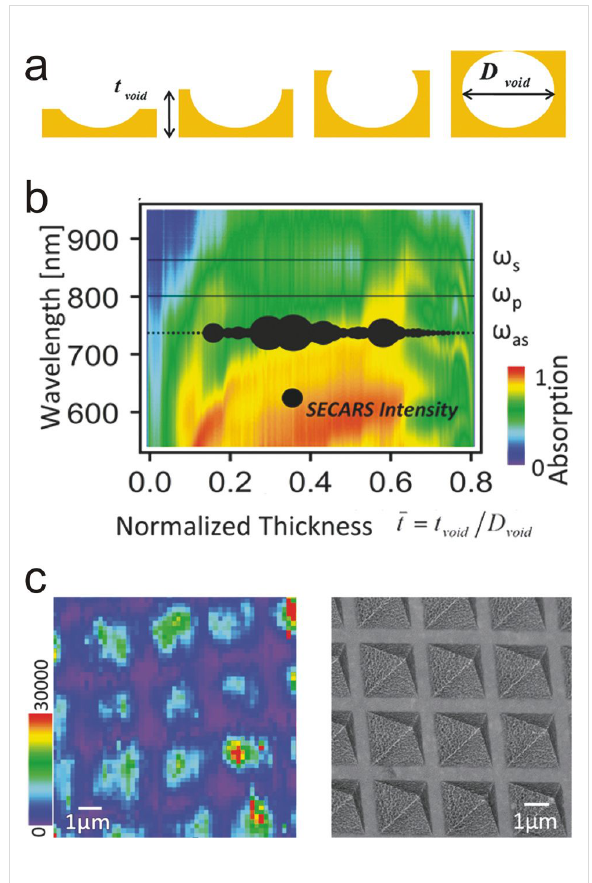
Figure 10: (a) Schematic representation of the gold nanovoids. Depending on the gold film thickness, the voids present various completeness levels. (b) UV–vis absorption mapping of 800 nm nanovoids as a function of their degree of completeness. For a specific thickness, the CARS and the pump frequencies can be both in reso- nance leading to large CARS intensities (black spot). (c) SE-CARS image of benzenethiol monolayer on the commercially available plas- monic surface Klarite (left) and corresponding SEM image showing the pyramidal pits of Klarite (right). Figure adapted with permission from [89], Copyright 2011 American Chemical